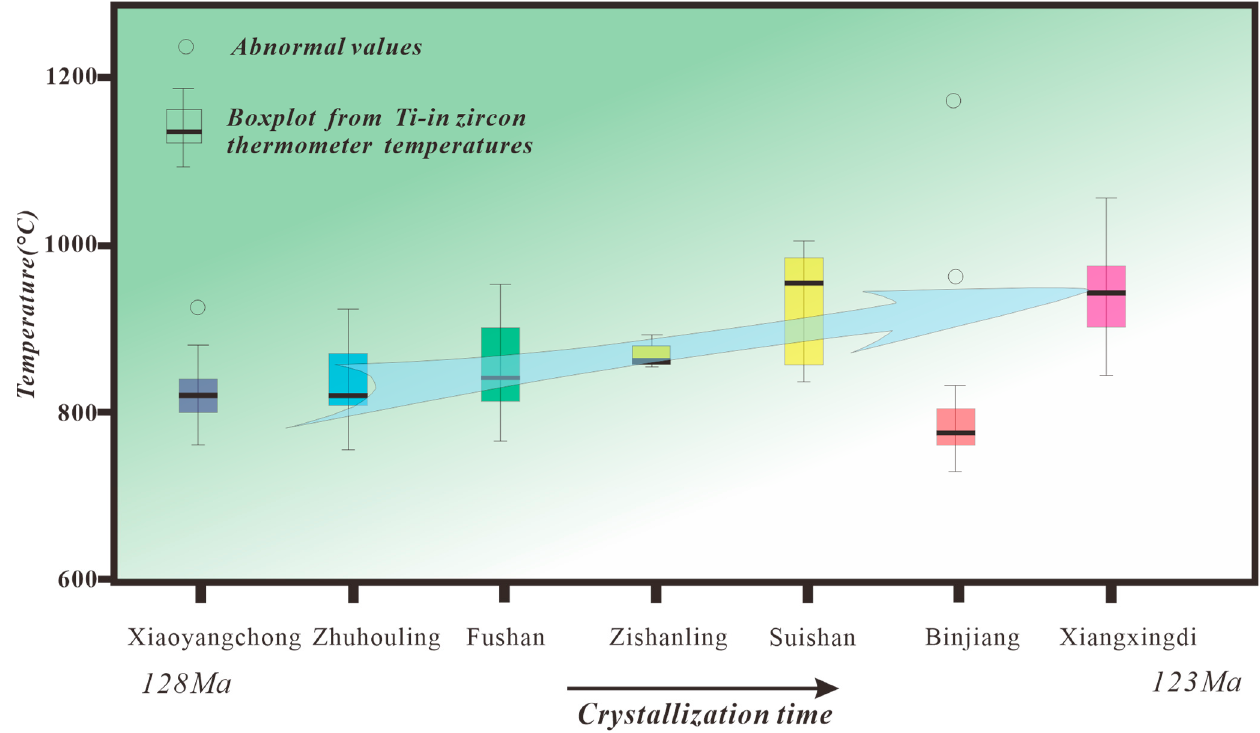
Figure 18. Crystallization temperature vs. crystallization time of A-type granites in the FVB (modified from [89]).